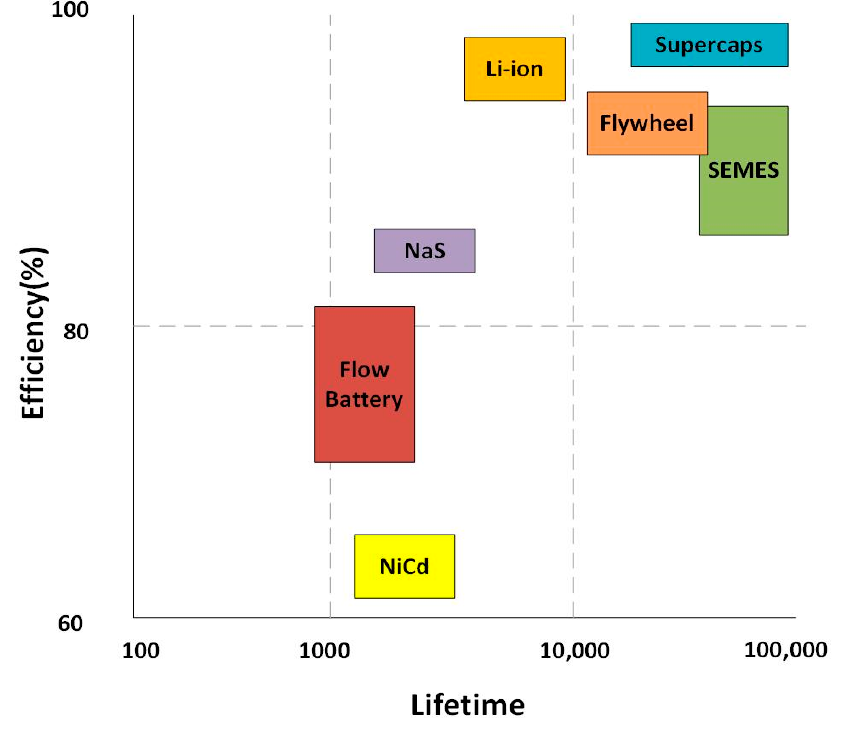
Figure 7. Types of storage devices according to operating time and efficiency [25].